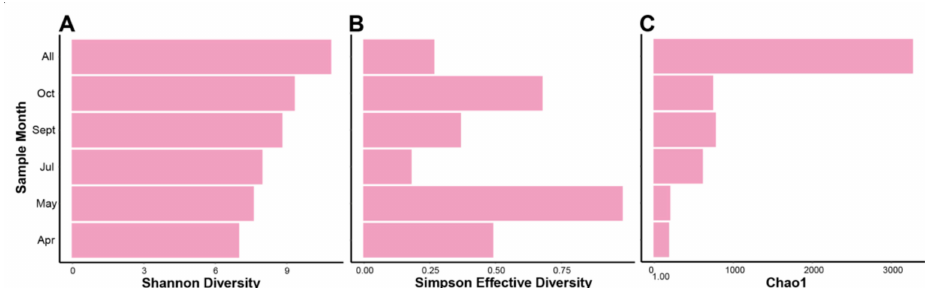
Figure 3. Alpha diversity indices of Illumina MiSeq metagenomic assemblies (contigs) as calculated by MerCat on k-mers of 21 bp, with a minimum count of 5 for each “k-mer species”. Indices include ( A ) Shannon’s diversity index, ( B ) Simpson’s diversity index, and finally ( C ) the Chao1 k-mer measures the number of k-mer species qualifying based on minimum count parameter. Sample months are indicated. The sample denoted “All” is an assembly of all reads from each Illumina MiSeq dataset